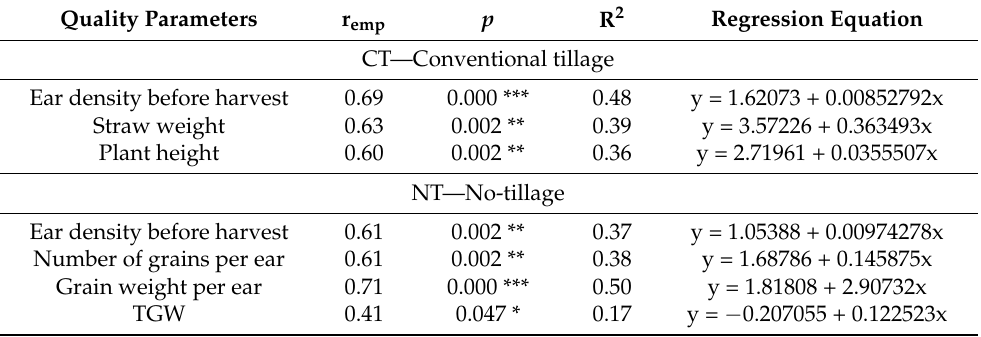
Table 5. Simple correlation coefficients, probability of significance, and simple regressions for the relationship between winter wheat yield and yield components under the different tillage